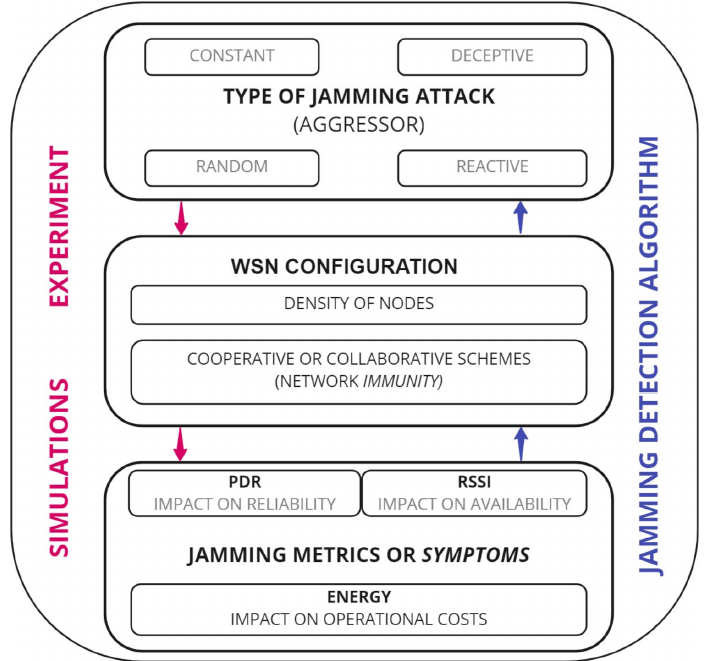
Figure 3. Proposed detection